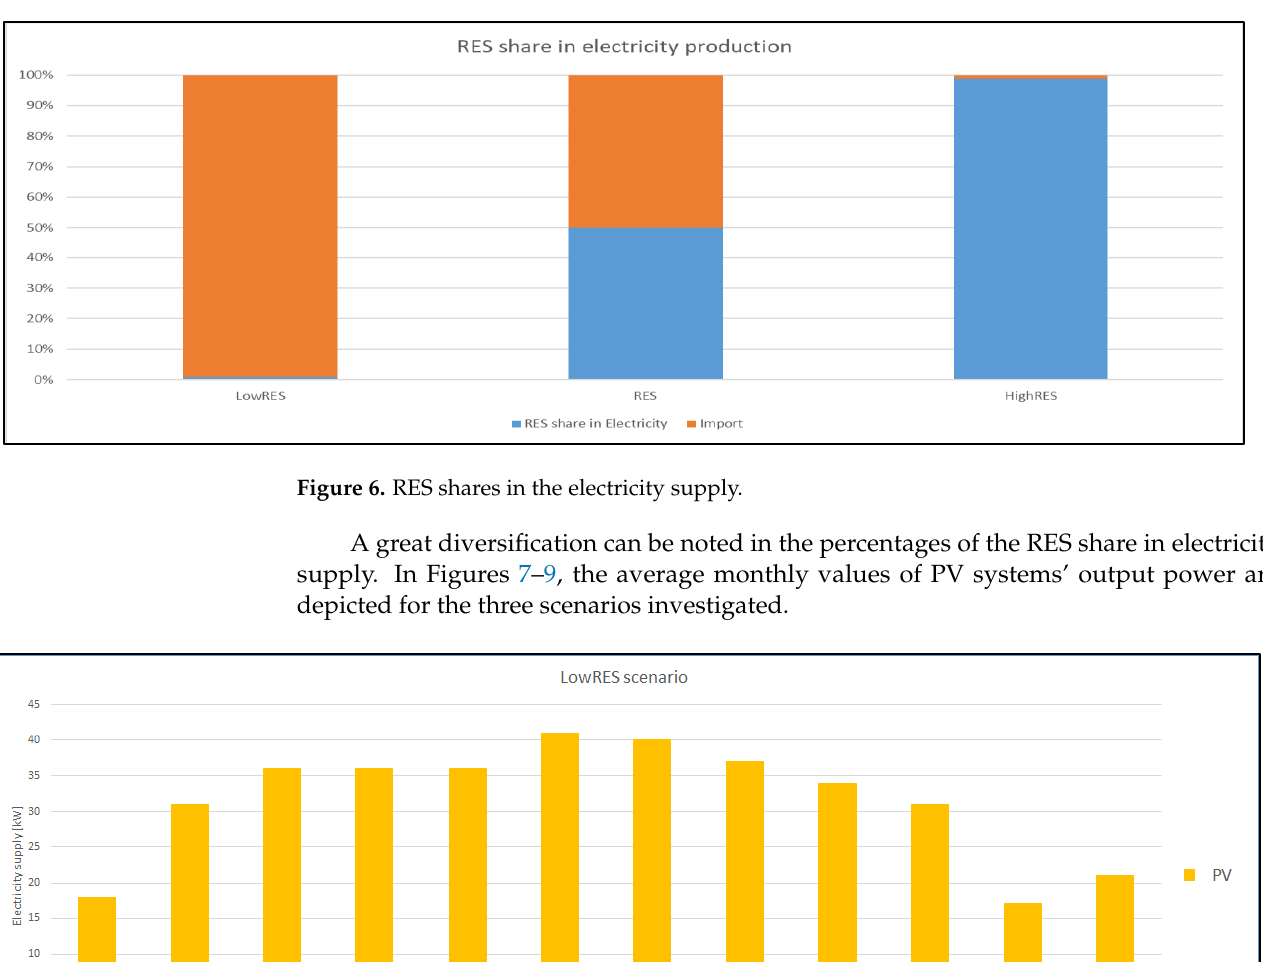
Figure 8. Average PV systems’ output power values for Scenario 2. Figure 9. Average PV systems’ output power values for Scenario 3 . Figure 10 presents the number of full-time equivalent (FTE) jobs in each scenario in- vestigated for 2030. Calculated for the last year of the analysis (2030), FTEs also need to be considered in the context of dynamics of the energy transition, which includes annual rates of installation for solar power.